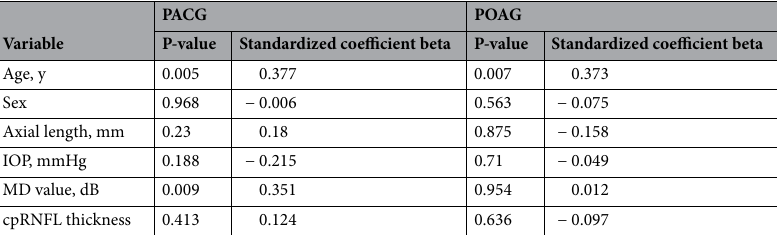
Table 3. Multivariate regression analysis of variables associated with the area of parapapillary beta zone in PACG and POAG groups. PACG: primary angle-closure glaucoma; POAG: primary open angle glaucoma; MD: mean deviation; RNFL: retinal nerve fiber layer; IOP: intraocular pressure.